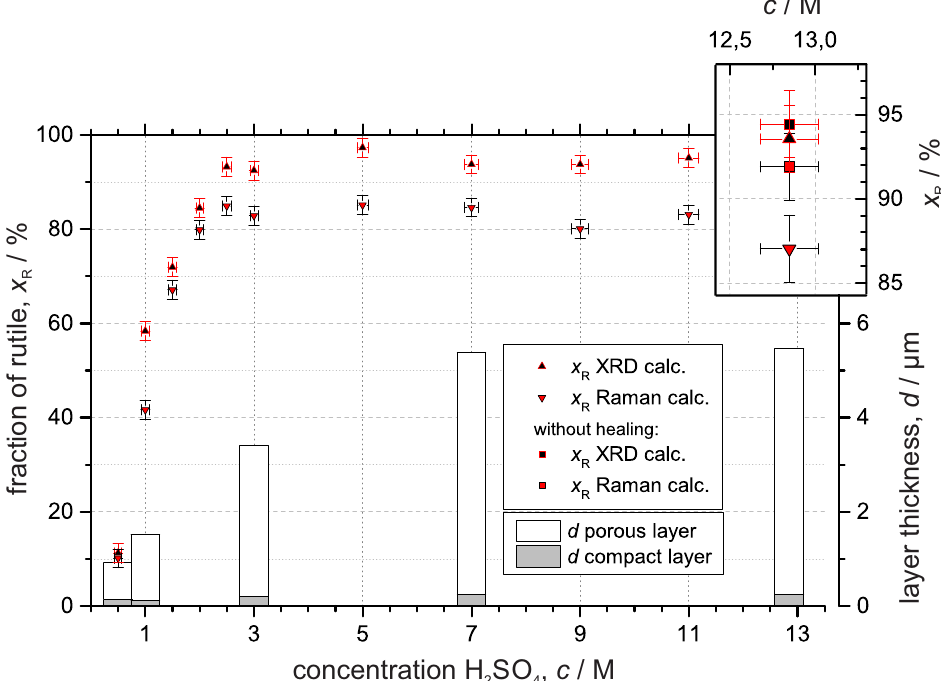
Figure 5. Experimentally derived weight fraction between TiO 2 crystal phases rutile and anatase in different samples as a function of H 2 SO 4 concentration. The fraction is presented with the estimated uncertainty of each sample and is determined from data acquired with XRD and Raman spectroscopy. The columns represent the thickness of the porous and compact oxide layer, as determined by SEM investigation on selected